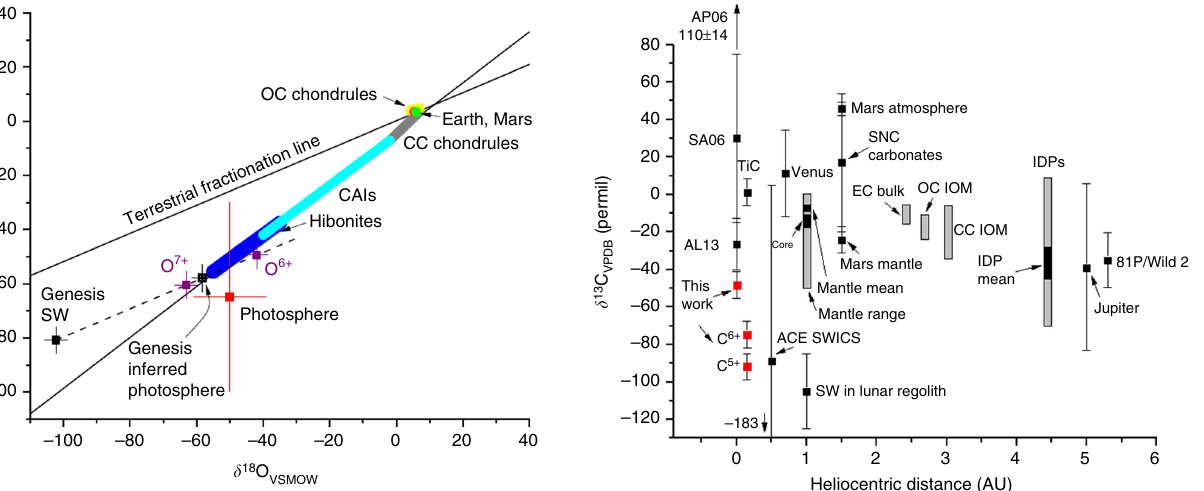
Fig. 5 Carbon isotope ratios in the solar system. The value for CO in the Sun (red squares, 1 σ errors) reported here is among the lightest in the solar system for bulk materials, and lighter than previously reported values, AL13 (ref. 12 ) and SA06 (ref. 10 ). The computed values for C 5+ and C 6+ ions in the solar corona 42 (in red) are similar to solar wind in lunar regolith 8 and to ACE SWICS measurements 29 , but differ from the ratio in TiC from Isheyevo 9 . Other reservoirs include Earth mantle diamonds (mean and range) 26 and core estimate 58 (Earth atmosphere is about 2 ‰ lighter than mantle mean), Venus atmosphere 59 , Mars atmosphere 60 , Mars mantle from SNC silicates 61 , and SNC carbonates 62 . Enstatite chondritic (EC) bulk C, ordinary chondrite (OC) insoluble organic matter (IOM), and carbonaceous chondrite (CC) IOM overlap with Earth mantle values 38 . The Jupiter and interplanetary dust particle (IDP) ratios spans a wide range 27,63 . Dust form comet 81 P/Wild 2 had ratios clustering in a fairly tight range 64 . The heliocentric distances shown for TiC, ECs, OCs, CCs, and IDPs are illustrative only. Additional reservoirs not shown here include Earth organic carbon, terrestrial and marine carbonate, minor organic components in carbonaceous chondrites, and various poorly constrained reservoirs such as Saturn, Neptune, and most comets 32 . It should also be noted that the fraction of C in Earth ’ s core could be as much as 90% (ref. 65 ), in which case the bulk Earth C isotope ratio would